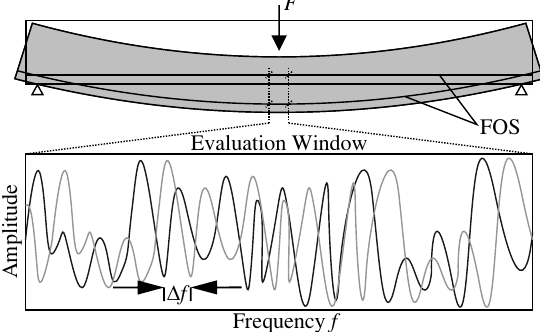
Figure 1. Frequency shift in the evaluation window caused by an exemplary